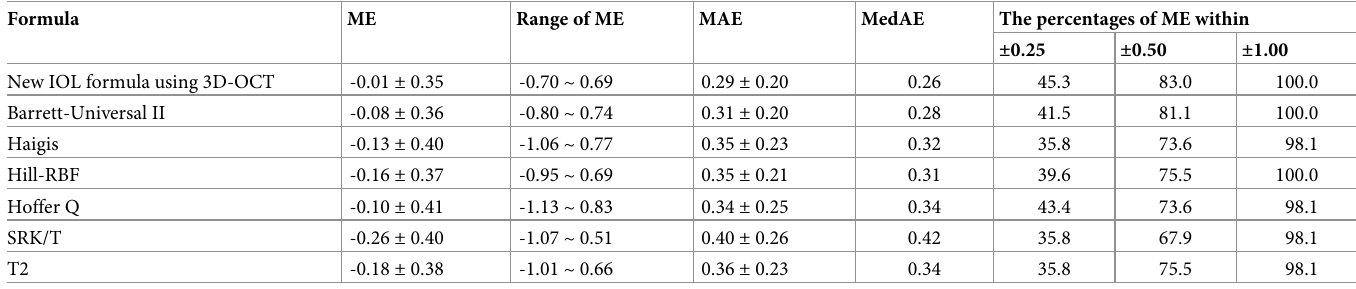
Table 7 shows comparison of the predictive accuracy between the new IOL formula and existing IOL formulas. New IOL formula produced the narrowest range of ME, smallest MAE, smallest MedAE, and highest percentages within ± 0.25 and ± 0.50 diopters. Table 7. Predictive accuracy derived from new intraocular lens (IOL) calculation formula compared with the accuracy of the Barrett-Universal II, Haigis, Hill-RBF, Hoffer Q, SRK/T, and T2 formulas in test set (n = 53). Formula ME Range of ME MAE MedAE The percentages of ME within ± 0.25 ± 0.50 ± 1.00 New IOL formula using 3D-OCT -0.01 ± 0.35 Barrett-Universal II Haigis Hill-RBF -0.16 ± 0.37 Hoffer